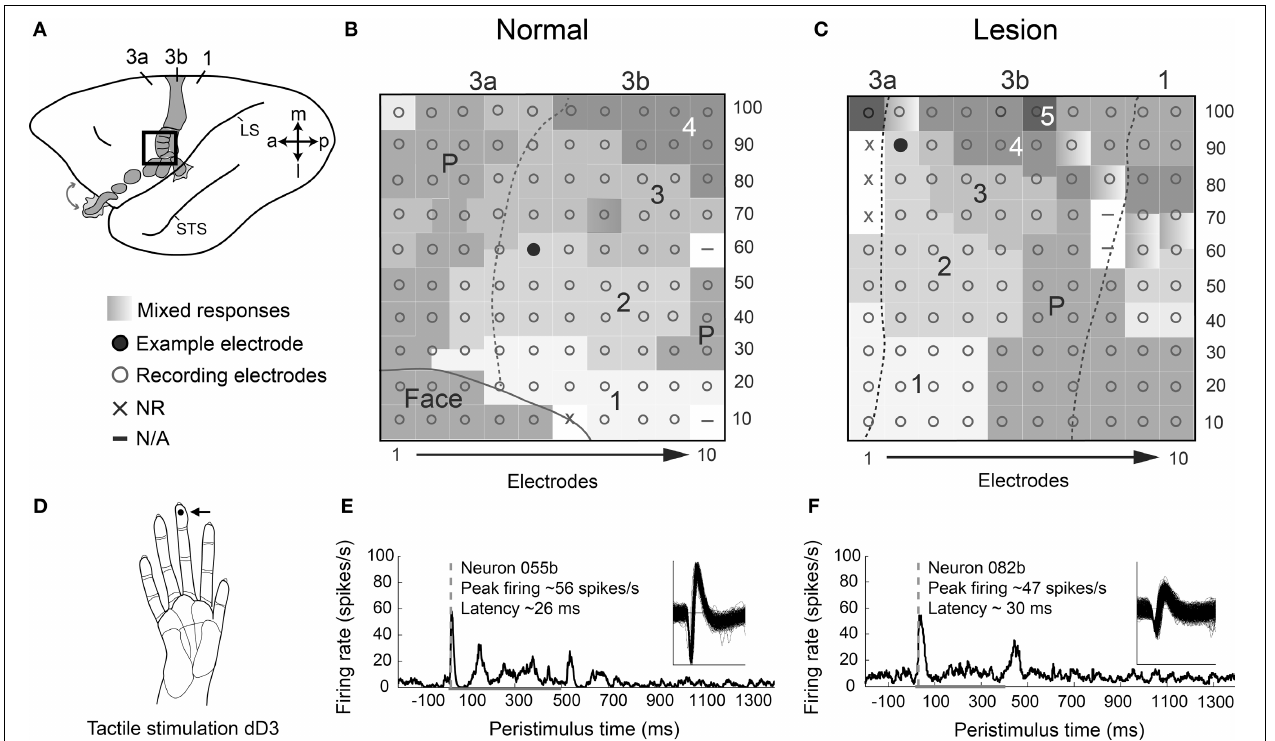
FIGURE 3 | Response properties of area 3b neurons after behavioral recovery from dorsal column lesion are similar to those in a monkey with no lesion. (A) A schematic of the left hemisphere of an owl monkey brain with area 3b shaded shows the approximate placement of a 100-electrode array for monkey OM-A with no lesion (see B ). The array placement for a monkey SM-G with a dorsal column lesion was similar, but slightly more medial and posterior (see C ). Note the key for the somatotopic mapping of the array applies to (B) and (C) . (B) Representation of coverage of 100-electrode array in cortex for a normal monkey with somatotopic map reconstructed from locations of receptive fields for neurons at each electrode. Coverage included part of the area 3b hand and face representation as well as area 3a, with somatotopy consistent with previous reports from normal monkeys. The electrode location from which the example neuron for the lower panel (E) was recorded is indicated by the filled circle. (C) Representation of coverage of 100-electrode array in cortex for monkey SM-G after behavioral recovery from partial DC lesion at the C6 spinal cord level. This lesion preserved many of the dorsal column afferents from digits 1 and 2. SM-G experienced sensorimotor training and testing using the impaired hand for 6 weeks following DC lesion prior to recording with the multi-electrode array. All digits are represented within expected somatotopic locations, but D1 and D2 appear to be represented in more